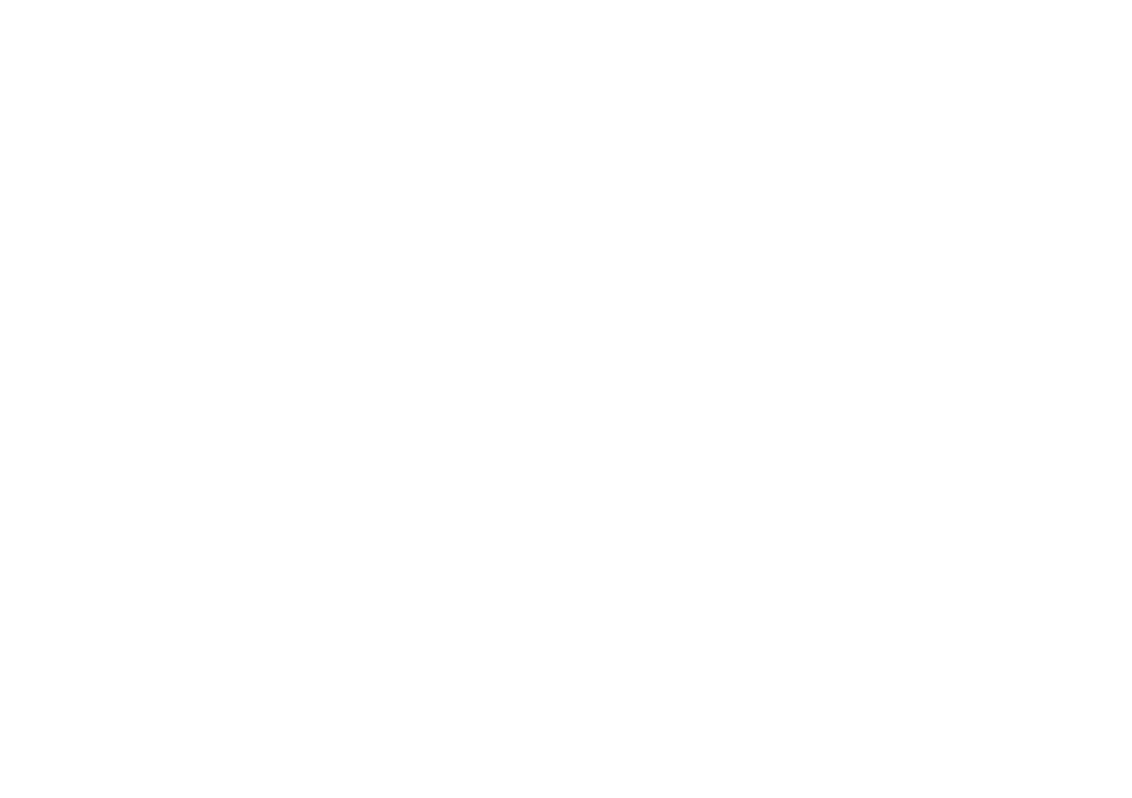
Figure 9. ( a–d ) Represent the PR curves on NUS-WIDE of all methods with different bits. (Created by “matlab R2019a” url: https:// ww2. mathw orks. cn/ produ cts/ matlab.